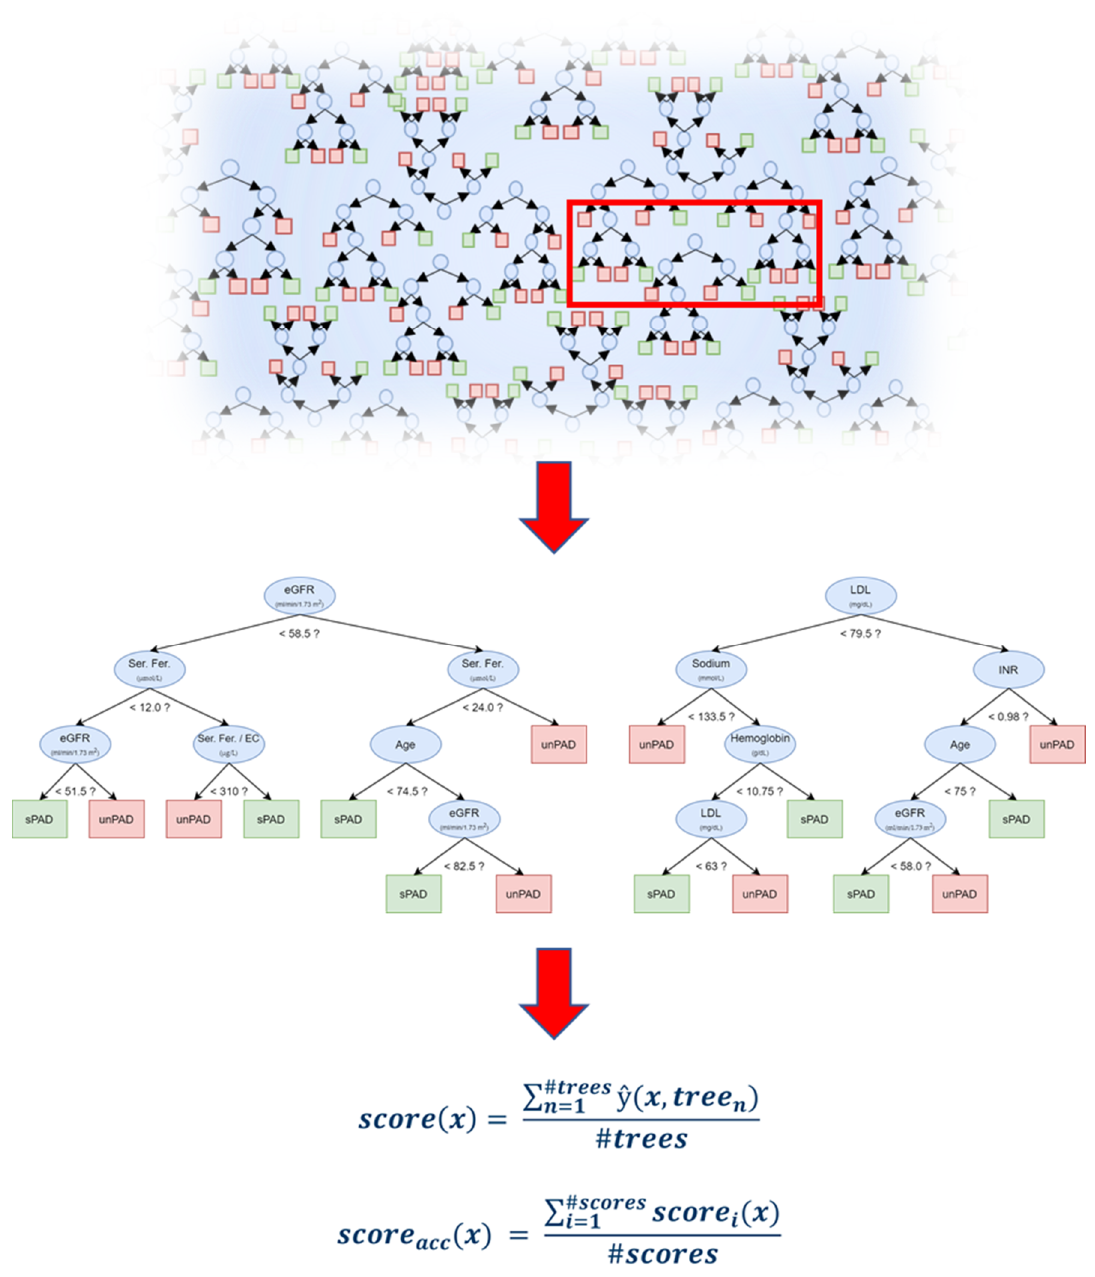
Figure 2. Schematic representation of the Random Forest ML algorithm and formula used to generate the AI-based score (AI-PAD). ‘?’ indicates an exemplary cut-off value (<) generated by the high throughput algorithm.